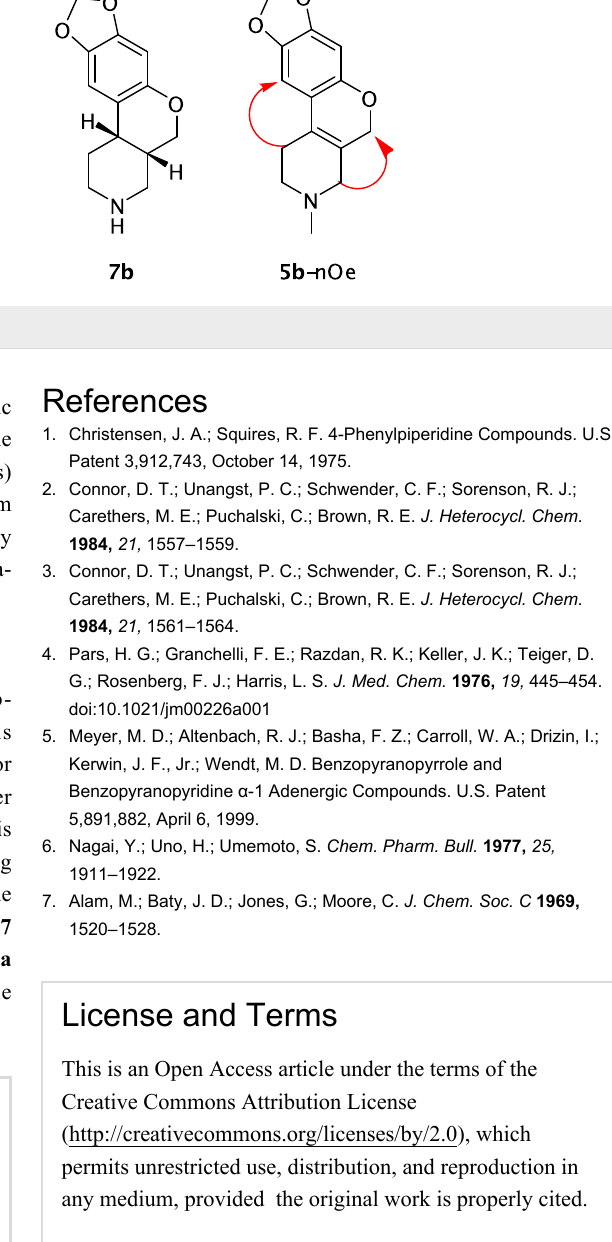
Figure 5: Structural elucidation.